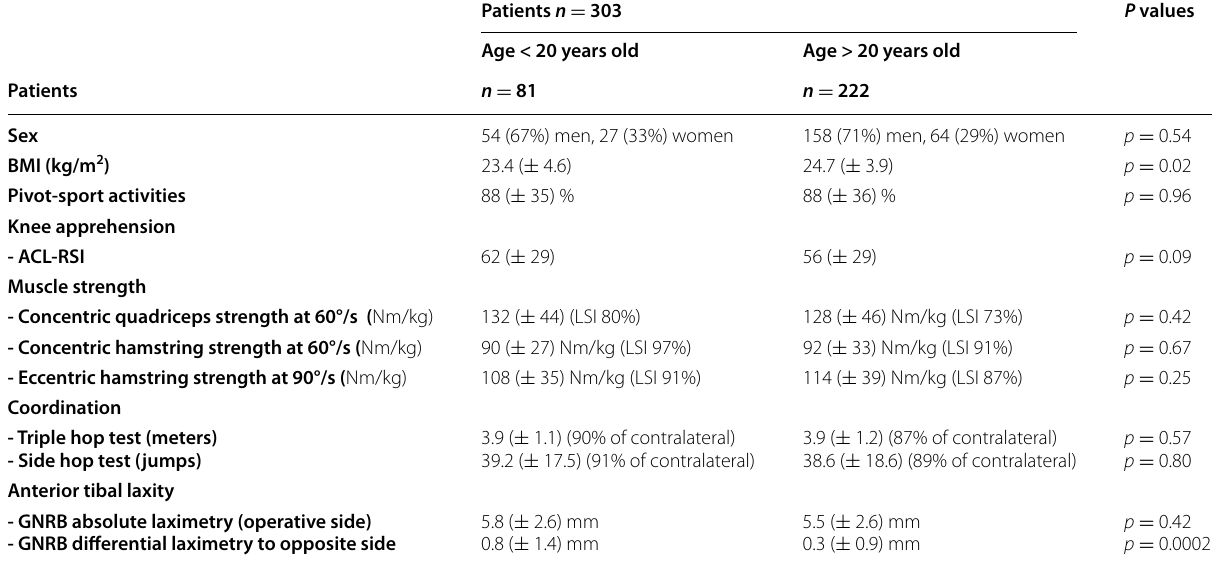
BMI Body mass index , ACL-RSI Anterior cruciate ligament return to sport after injury, LSI Limb symetry